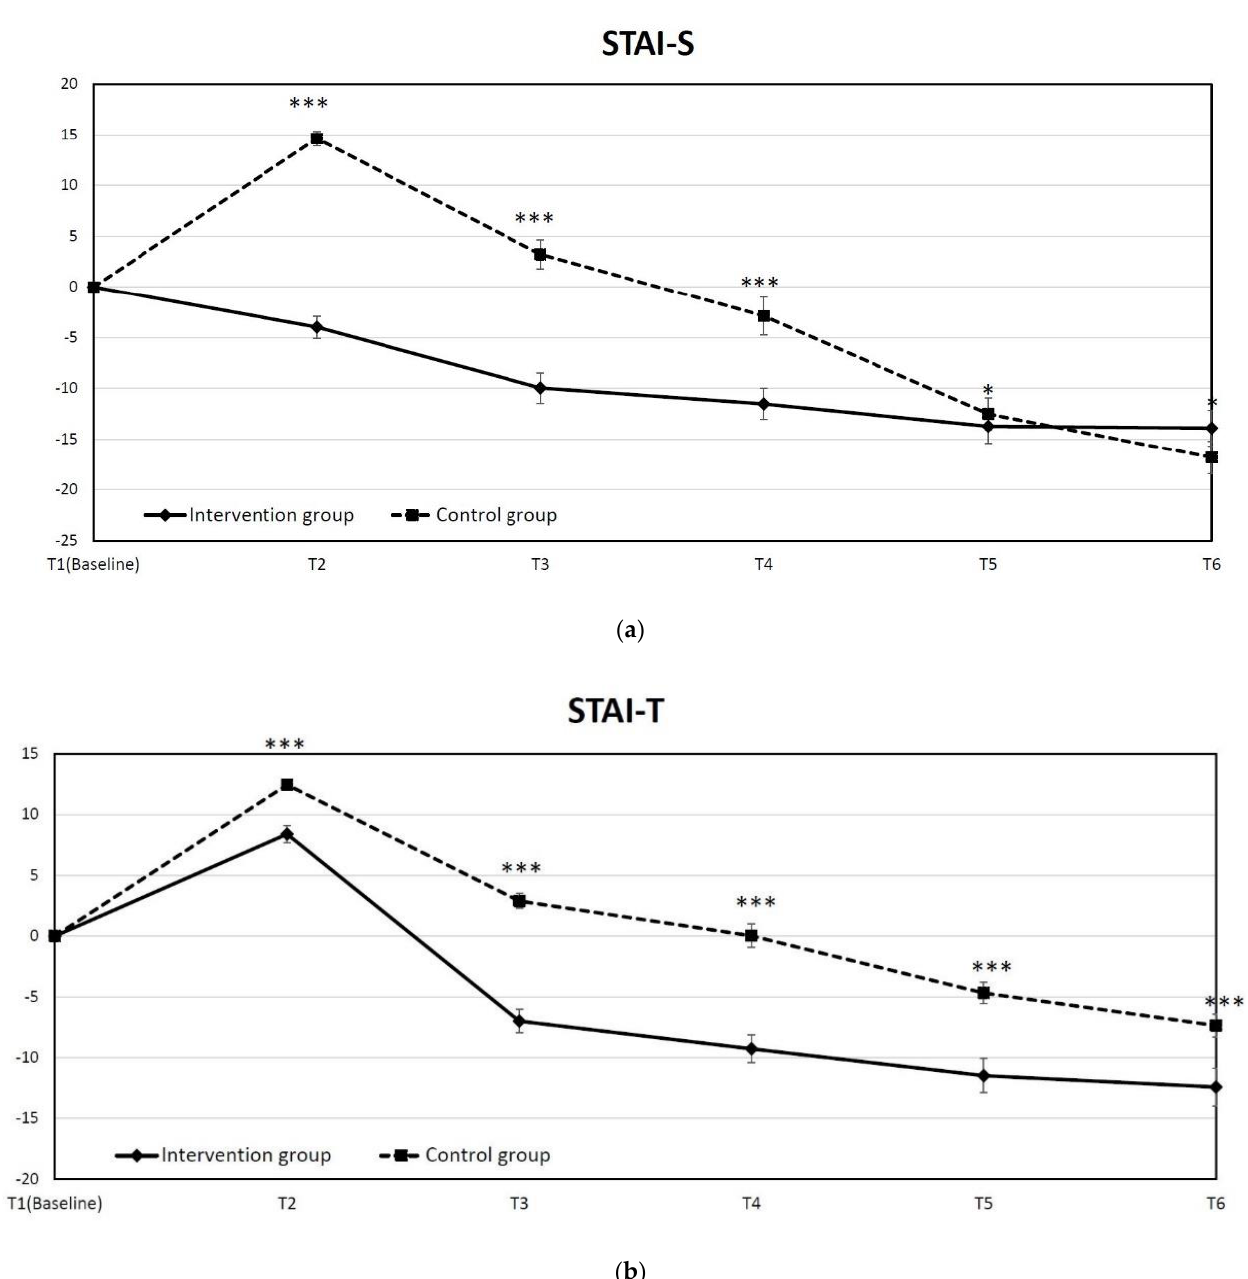
Figure 3. Time course of mean change in anxiety state from baseline to each checked time point: ( a ) state anxiety (State-Trait Anxiety Inventory, STAI-S), ( b ) trait anxiety (State-Trait Anxiety Inventory, STAI-T). (* p < 0.05, *** p < 0.001).